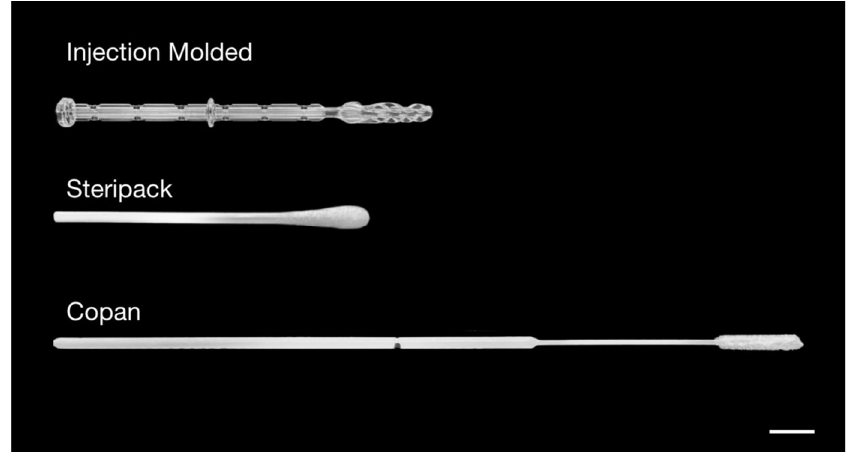
Figure 1. Experimental swabs. Macro images of ClearTip™ injection-molded, Steripack, and Copan anterior nasal swabs used in these studies. Scale bar = 10 mm.